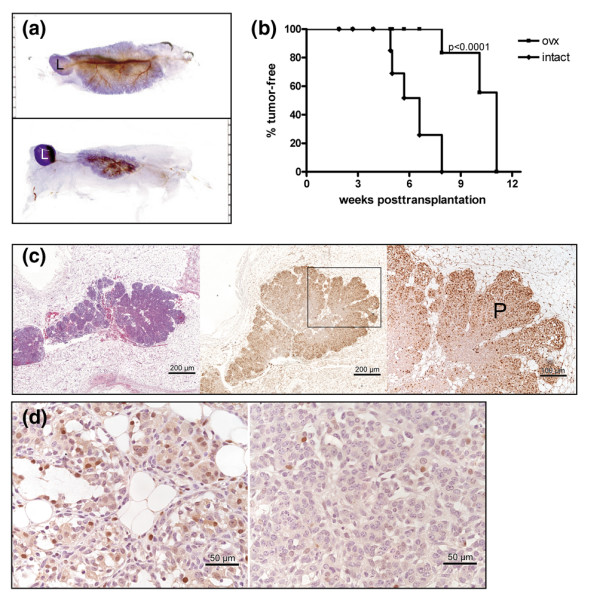
Effect of ovarian hormone on the development of mammary intraepithelial neoplasia outgrowths (MIN-Os) and tumors. (a) Whole-mount images, from intact (top panel) and ovariectomized (bottom panel) murine host mammary fat pads into which 8w-B premalignant MIN-O tissue had been transplanted. MIN-O (dark blue) is significantly larger in the intact host fat pad at 5 weeks after transplantation than in the ovariectomized host fat pad. Lymph node (L) is seen at the left side of the MIN-O. (b) Effect of ovarian ablation on the 8w-B MIN-O line tumor development. Time to palpable tumor was significantly longer in ovariectomized mice (n = 8) than in the intact ones (n = 4). (c) Immunohistochemical staining of the proliferation marker Ki-67 on MIN-O (center and right). The growing edge of the MIN-O is highly proliferative, as seen by intense Ki-67 staining (brown, 10× field, center). A 20× field of the boxed area is shown on the right. The proliferative area (P) is indicated. Corresponding H & E staining is shown on the left. (d) Immunohistochemical staining of estrogen receptor (ER)-α on MIN-O (left) and tumor (right) from 8w-B-line animals at 10 weeks after transplantation. Areas with strong nuclear ER staining as well as cytoplasmic staining were often found in the MIN-O tissue (left). In general, ER staining in tumor tissue was less intense and less frequent (right). ovx, ovariectomized.